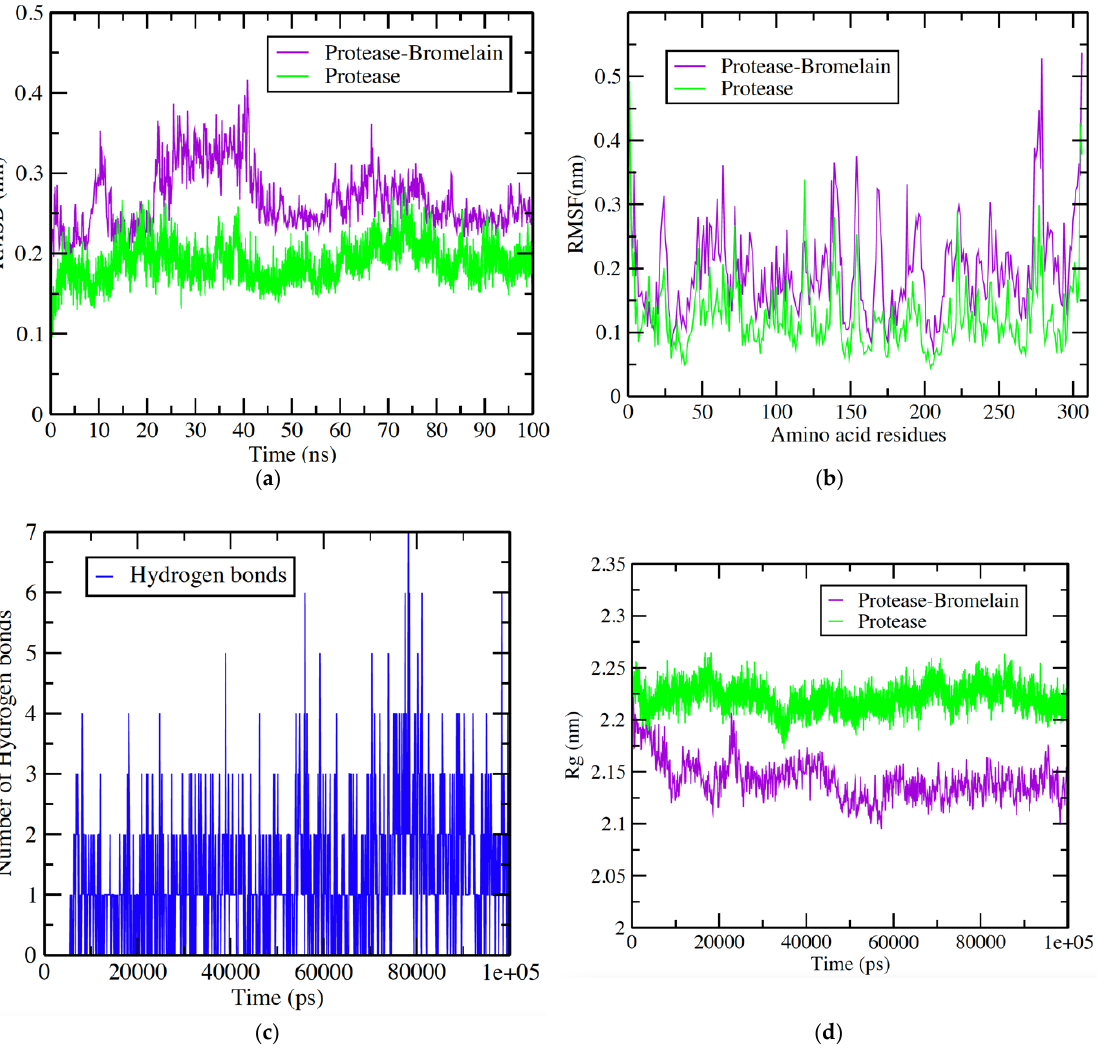
Figure 5. Graphical representation of ( a ) RMSD plot of protease in water (Green color) and protease– bromelain complex (Purple color) deviation during 100 ns period; ( b ) RMSF plot with fluctuation per residue; ( c ) hydrogen bond plot showing formation hydrogen bond (blue color) during 100,000 ps period; ( d ) radius of gyration (Rg) plot showing compactness of protease molecule during 100 ns simulation. Where nm = nanometer; ps = picosecond.